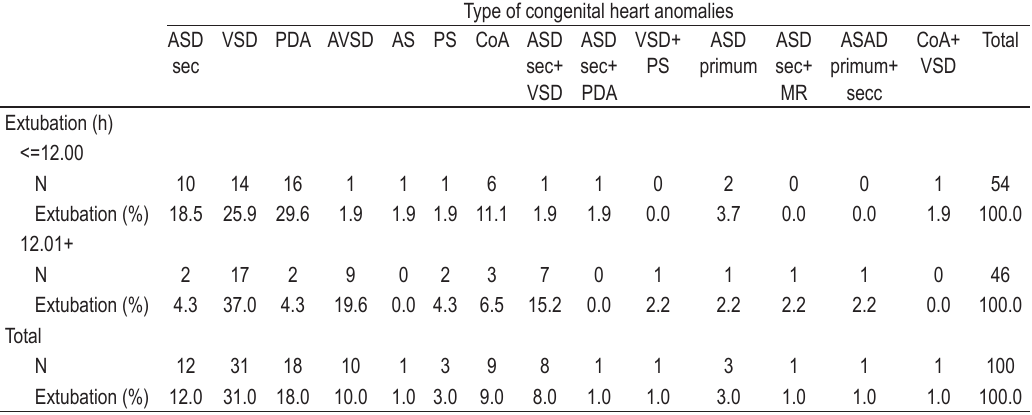
TABLE 3. The frequency of certain types of CHD compared to the group of respondents Type of congenital heart